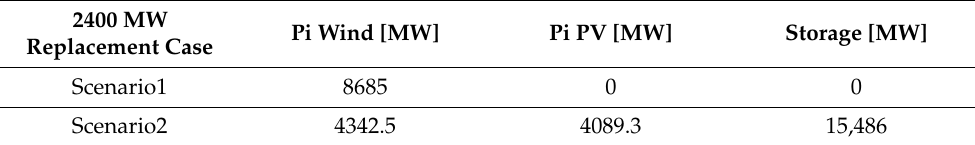
Table 5. The 2400 MW replacement case.